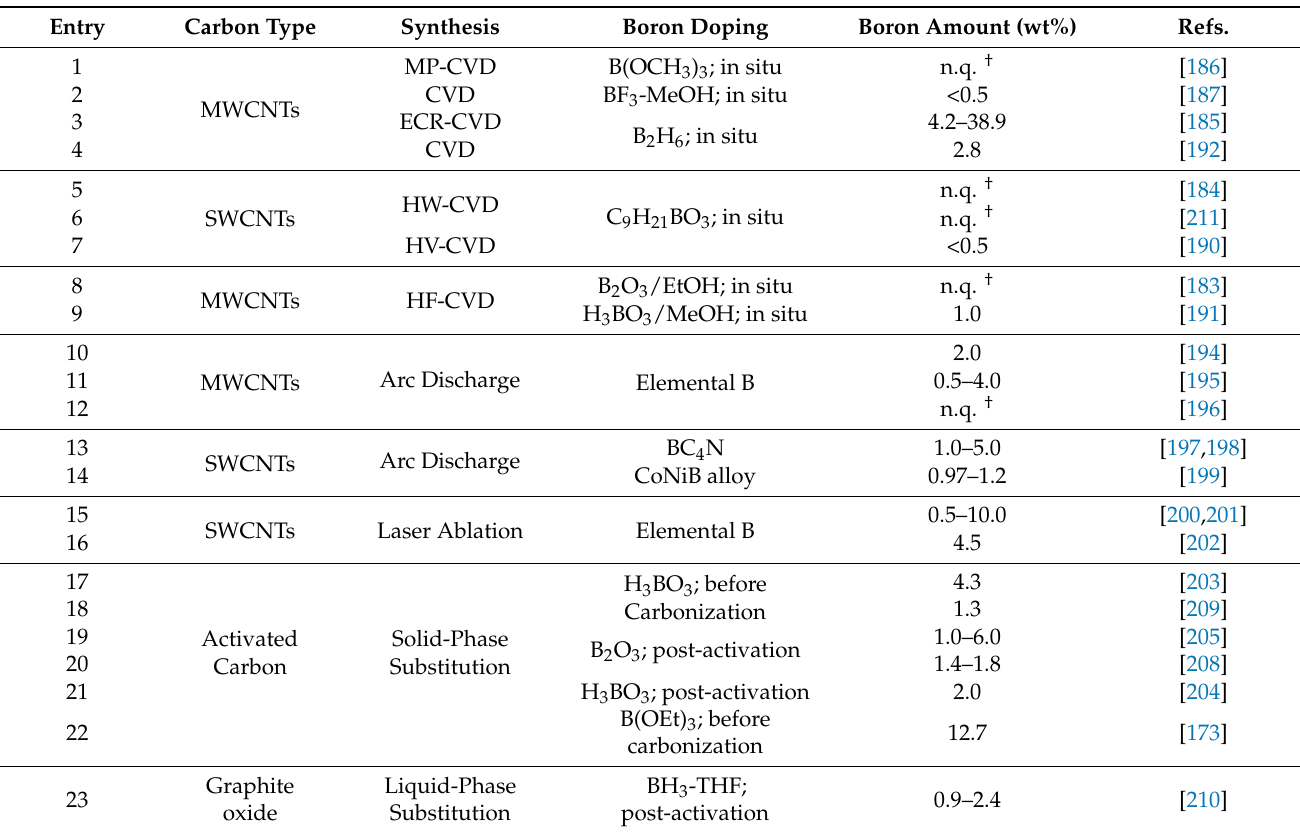
Table 3. Summary of the boronation procedures reported in this